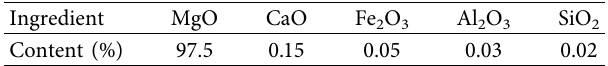
Table 1: Data of neurotransmitter substances in plasma of control